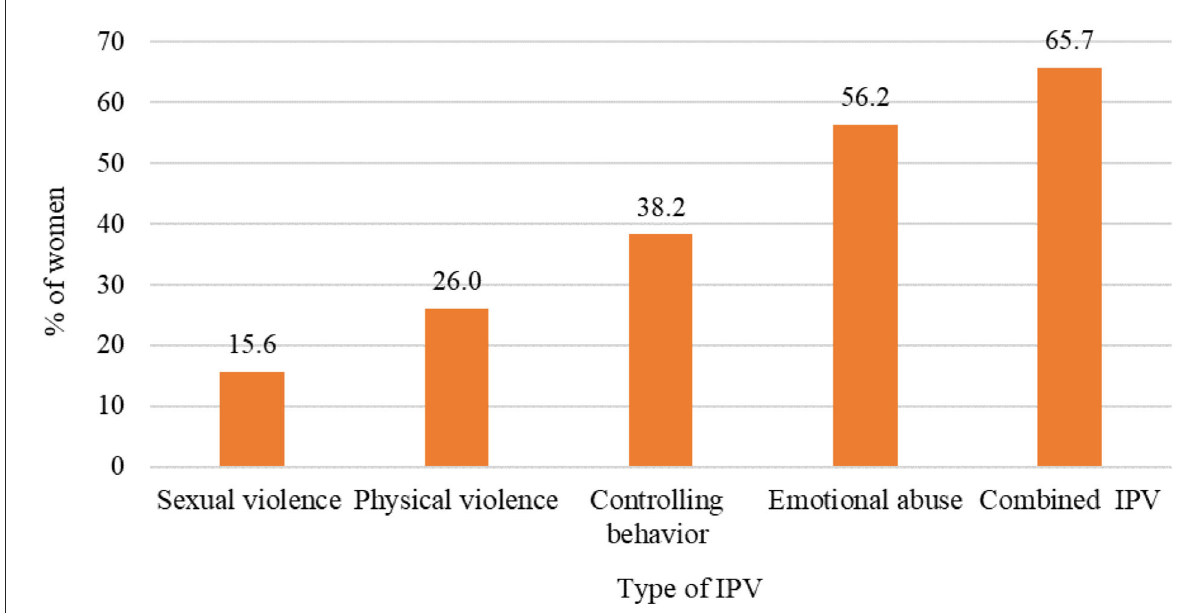
FIGURE1 Magnitude and types of intimate partner violence among HIV-positive women in a discordant